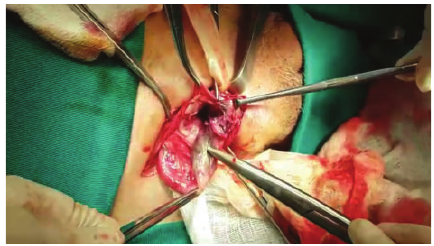
Figure 4: Necrosis of the apex of the